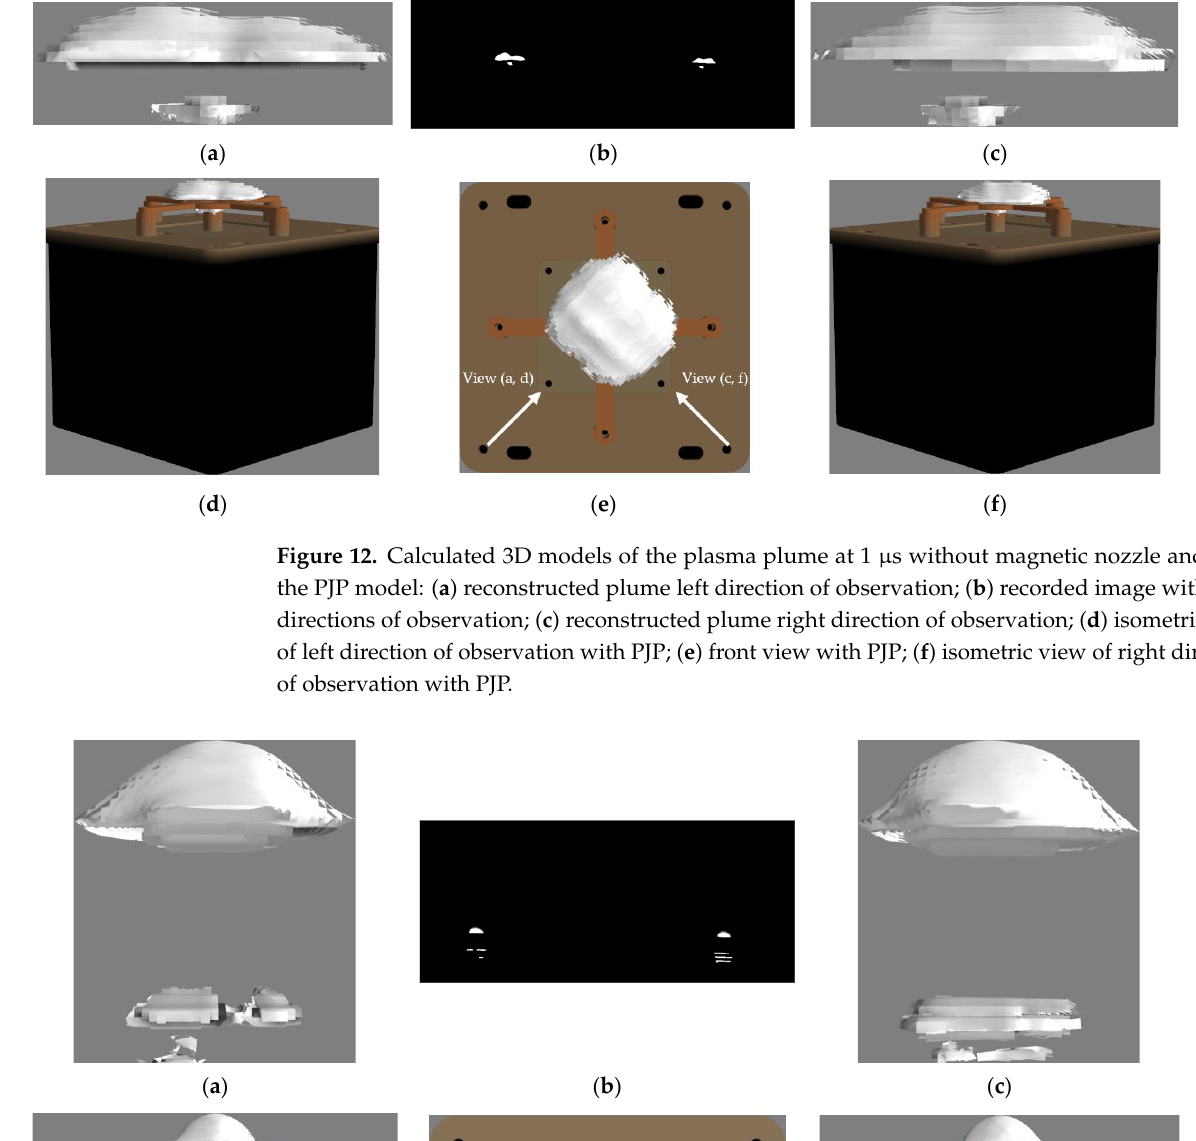
Figure 11. Calculated areas (blue: left direction of observation; green: right direction of observation) from the sliced contours of both perspectives: ( a ) thruster without magnetic nozzle; ( b ) thruster with magnetic nozzle.